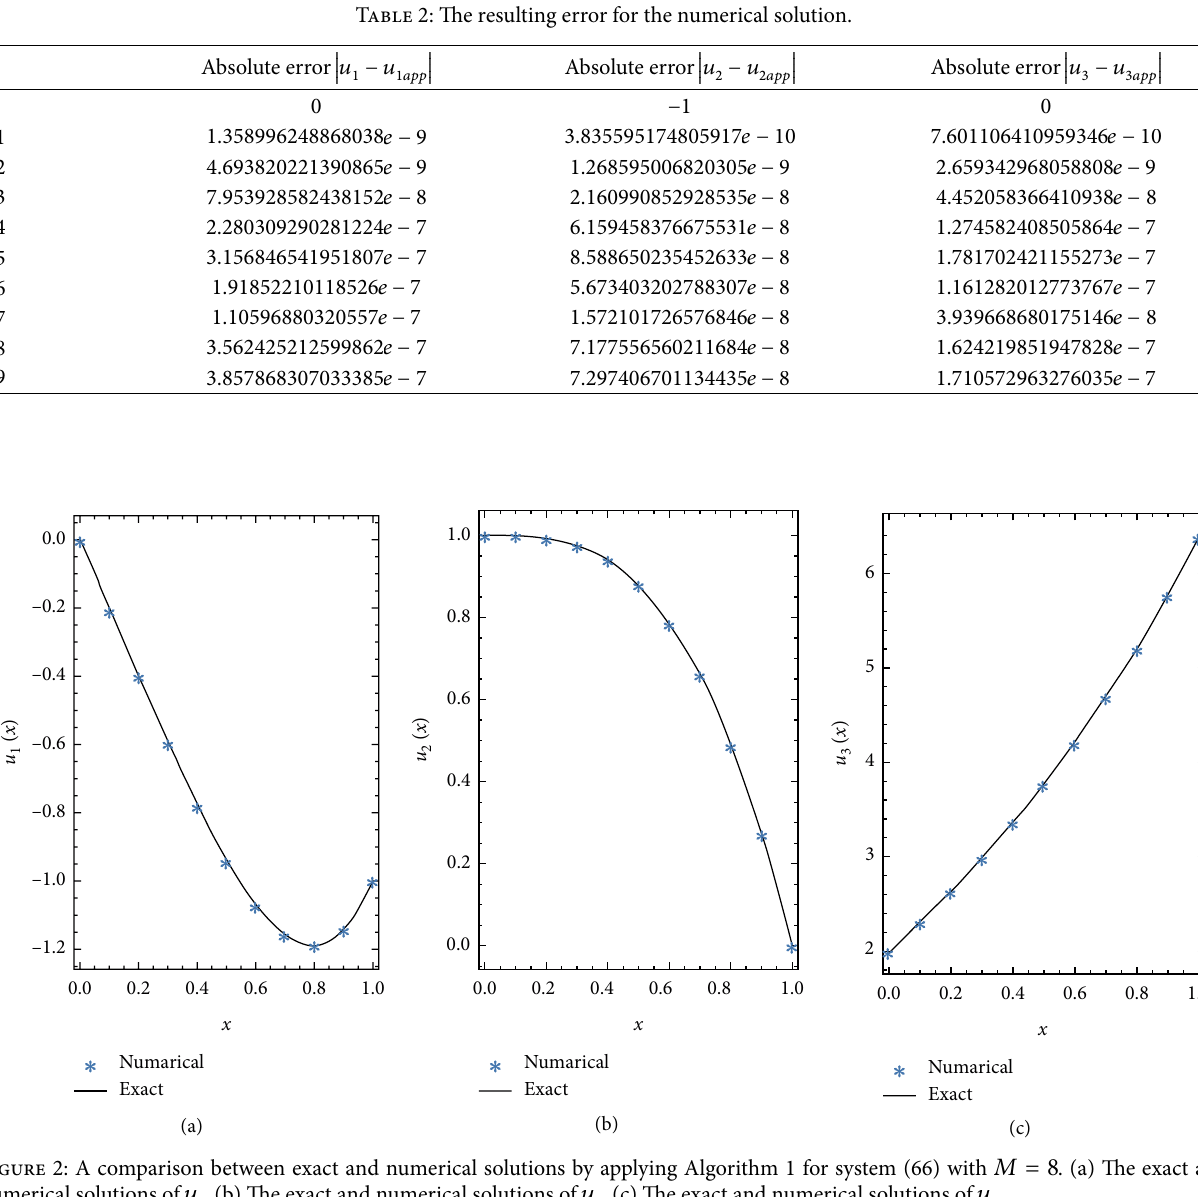
. (c) The exact and numerical solutions of 𝑢 2